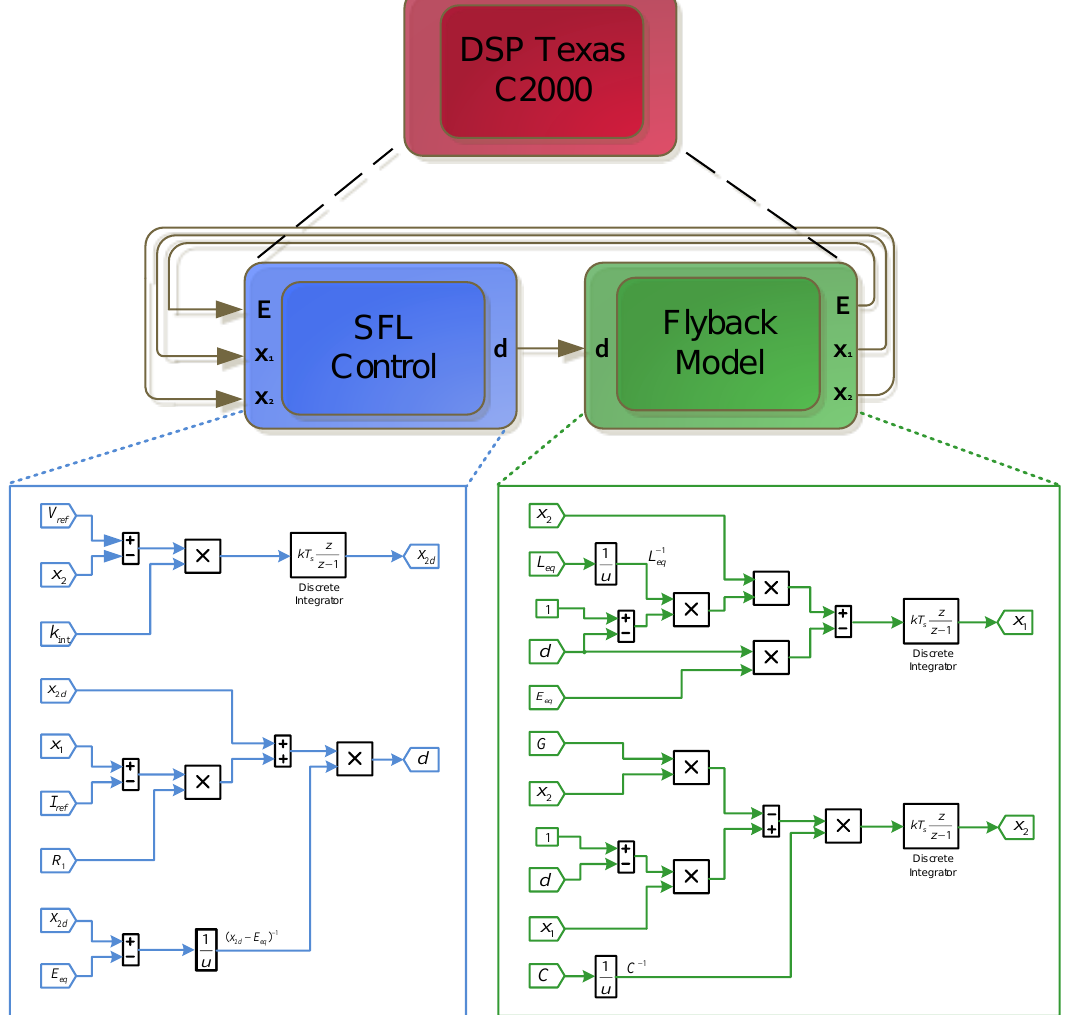
Figure 4. Flyback model, Equations (8) and (9), and SFL control Equation (10) in block diagrams (high level programing) that is embedded in DSP